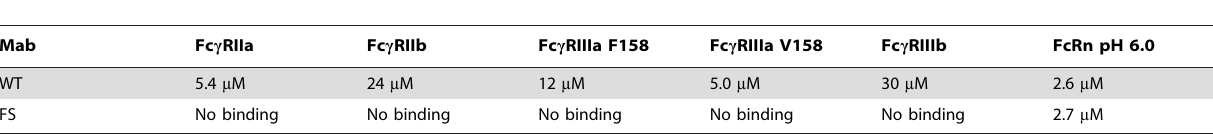
Table 1. Equilibrium dissociation constants K D of antibody wild type and Variant FS to Fc receptors.